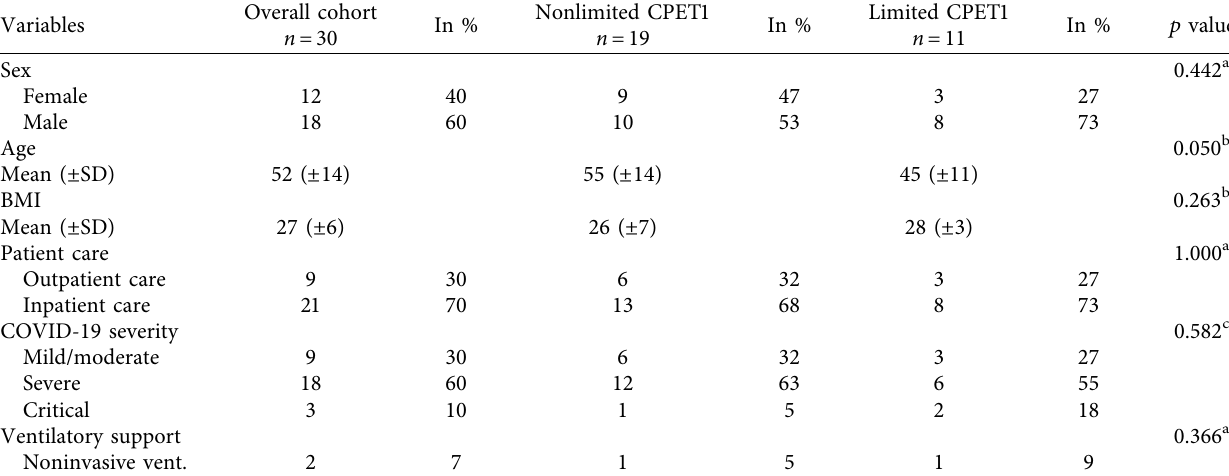
Table 2: Comparators of non-CPET